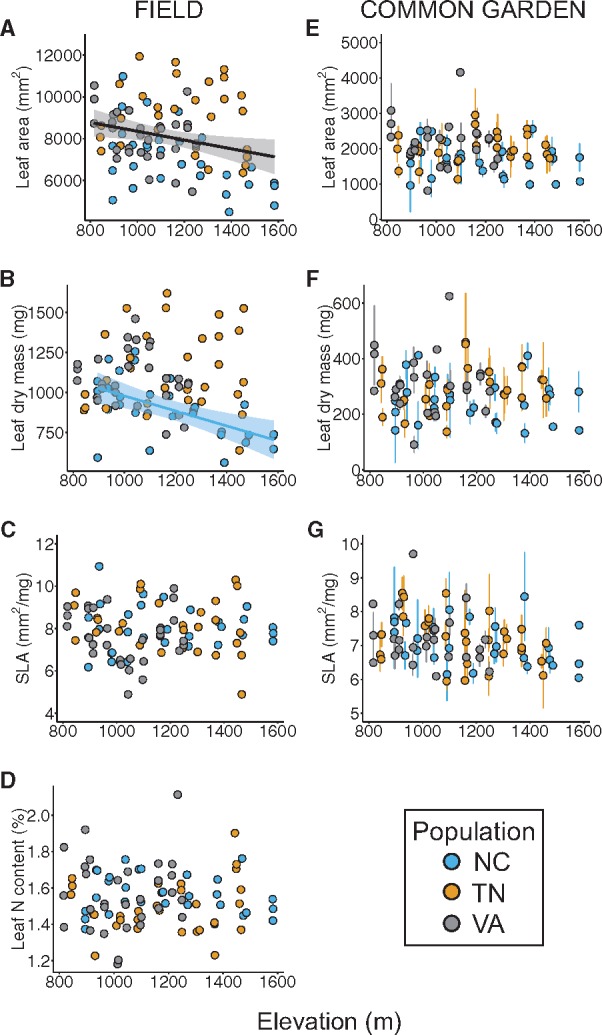
The effect of elevation on leaf-level traits (leaf area, leaf dry mass, specific leaf area [SLA], leaf nitrogen [N] content) in Rhododendron maximum measured at the individual level in natural field populations along three elevation gradients (A–D) and the effect of source elevation on mean ± SE trait values measured at the replicated cutting level in a common garden (E-G; leaf N content was not measured in the common garden). Populations are represented by each of three colors (North Carolina, blue; Tennessee, orange; Virginia, grey). A solid black line indications a significant (P < 0.05) effect of elevation across populations (no population-by-elevation interaction). When statistical models detected significant or marginally significant population-by-elevation interactions, colored regression lines corresponding only to those populations in which traits varied significantly (P < 0.05) along elevation are shown. The shaded region around each line represents the 95 % confidence interval for that regression.